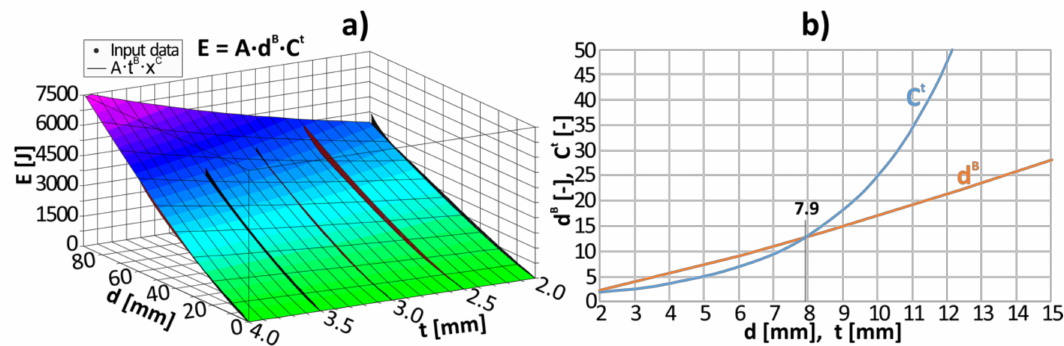
Figure 7. The energy absorption model ETMEA: ( a ) graphical representation; ( b ) the influence of crucial factors on energy absorption.